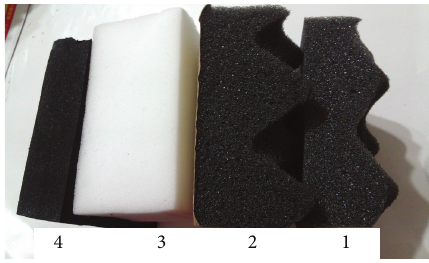
Figure 1: Foam experimental